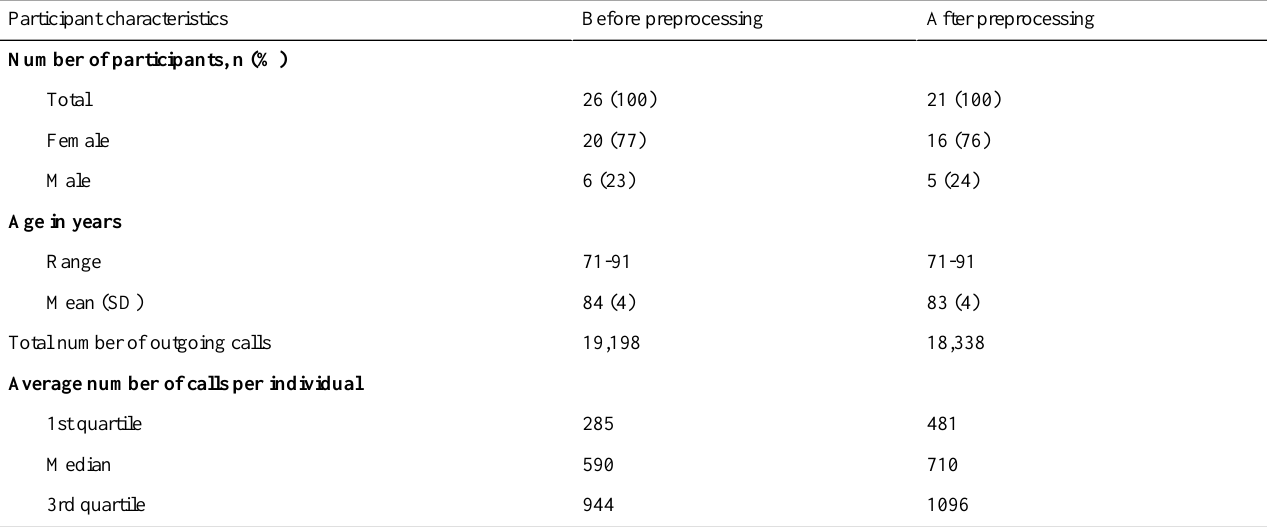
After preprocessingBefore preprocessingParticipant characteristics